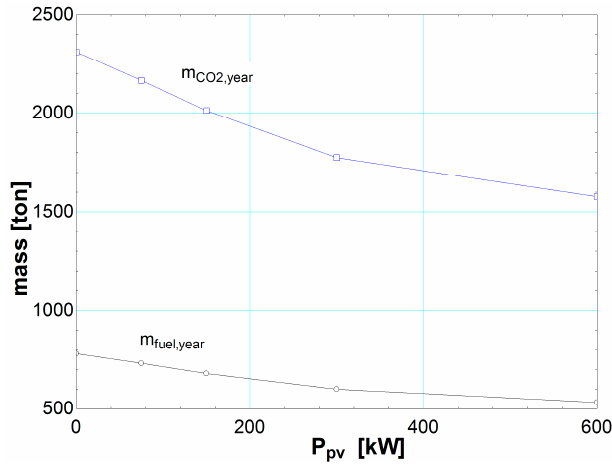
Figure 8. Parametric study: annual consumption of fuel and CO 2 emissions for different photovoltaic subsystem capacities ranging from 0 to 600 kW e .